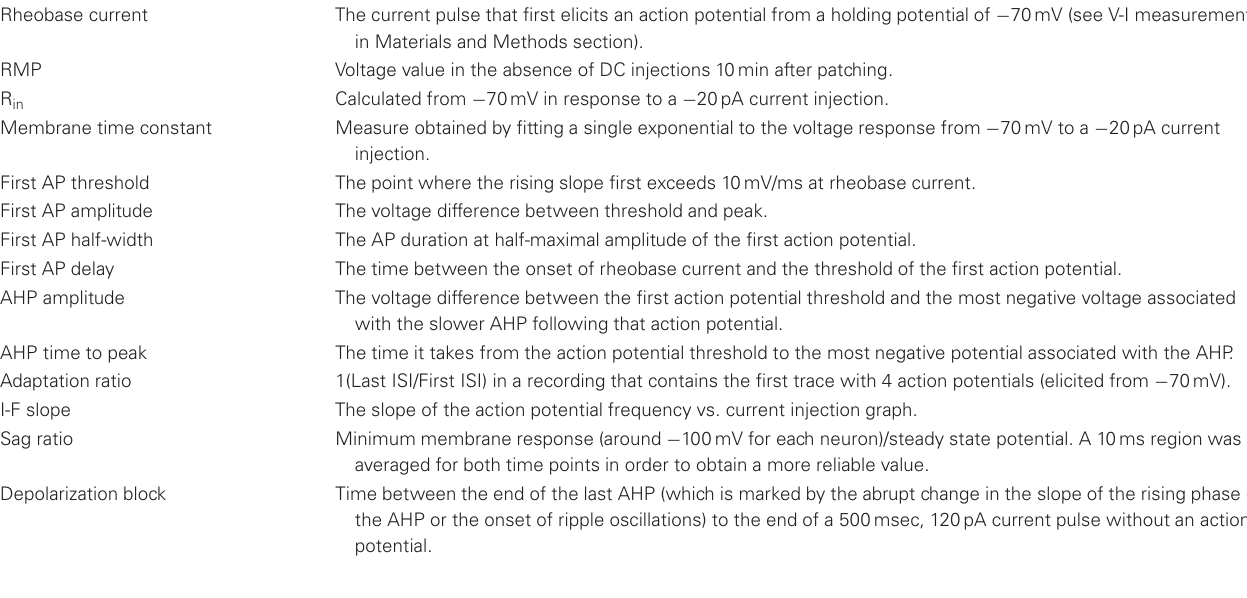
Table 1 | Physiological properties examined in this study and their operational